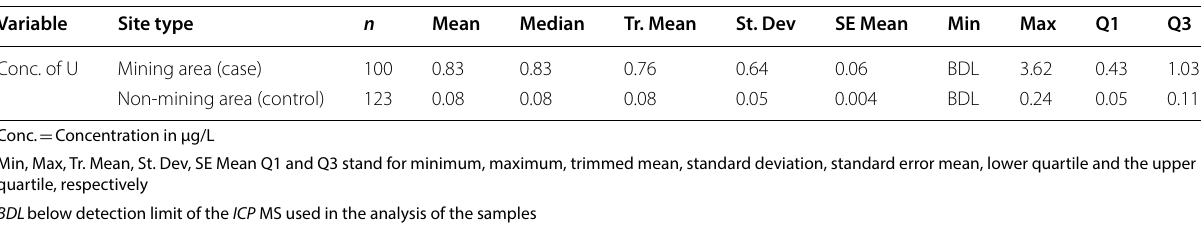
Table 1 Summary statistics for U contamination in milk Descriptive statistics